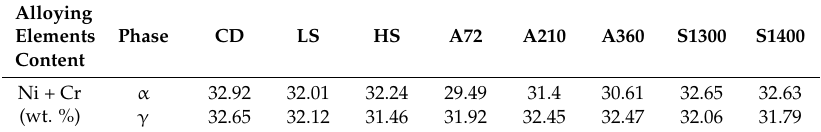
Table 5. Sum of Nickel and Chromium contents (wt. %), key elements in the liquid metal erosion/corrosion phenomena between liquid aluminum and solid steel.